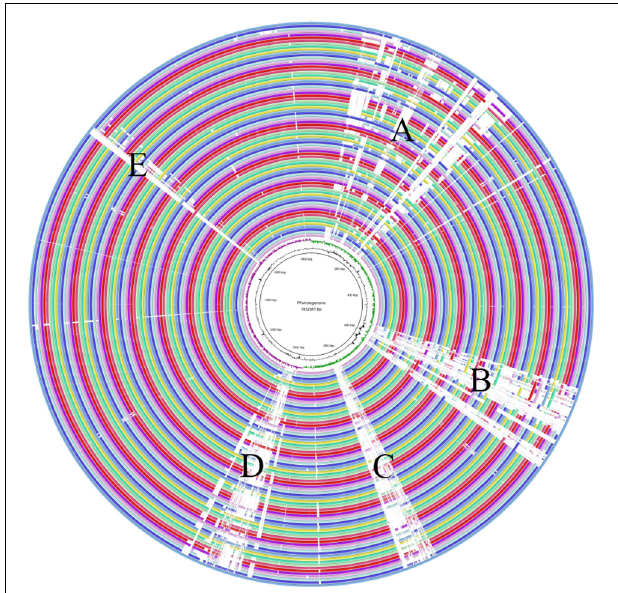
FIGURE 7 | The whole genome comparison. Region A mainly included genes related to defense mechanism, amino acid and carbohydrate transport and metabolism, and cell wall/membrane/envelope biogenesis. Region B related to the cell wall/membrane/envelope biogenesis. Region C and Region D were both phage related. Region E consisted of genes associated with stress response, secondary metabolites biosynthesis and carbohydrate transport and